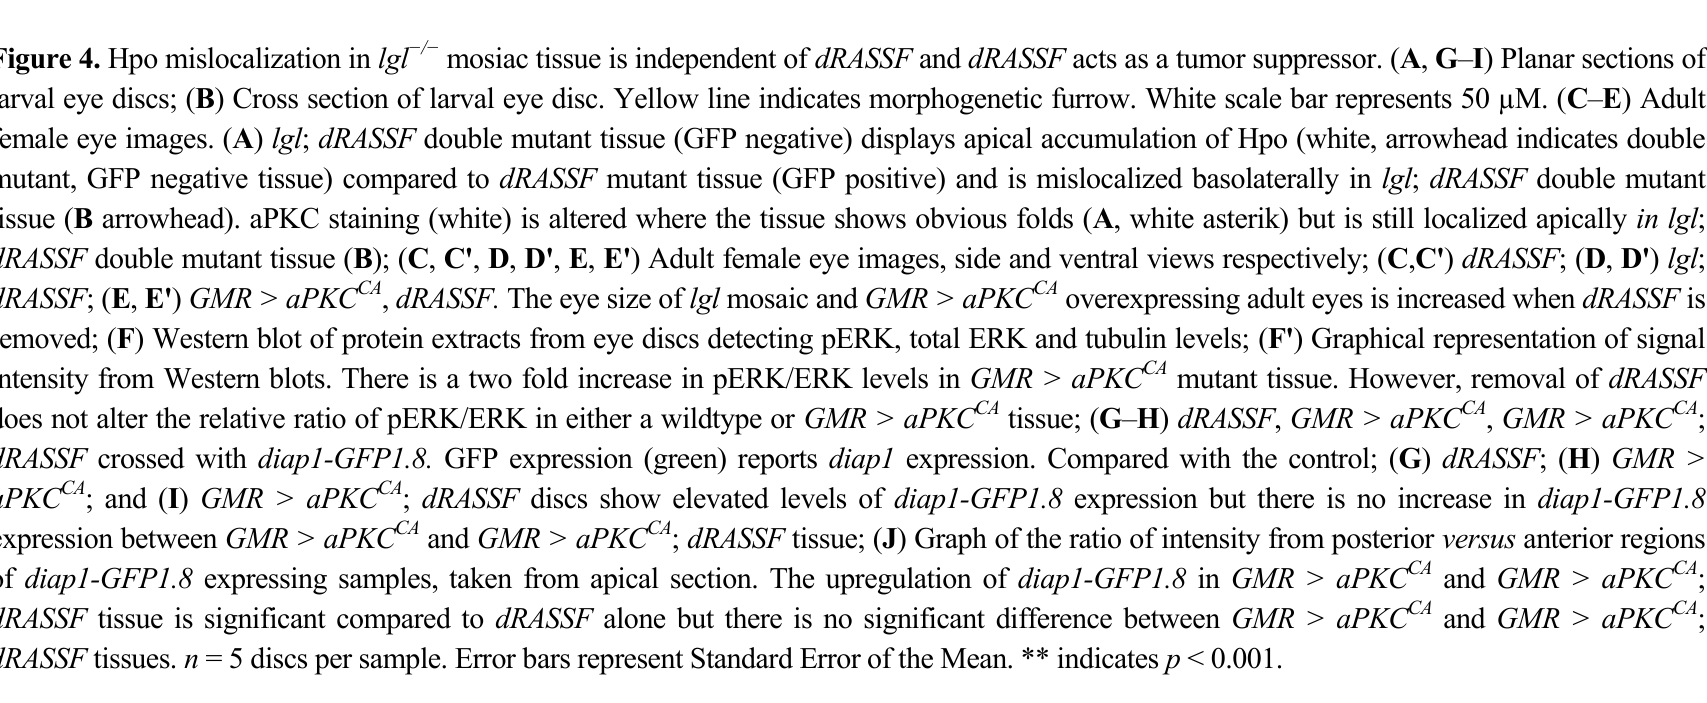
( A , B ) lgl ; dRASSF : eyFLP ; lgl 27S3 , FRT40/UbiGFP , FRT40 ; dRASSF X36/X36 ; ( C ) Control dRASSF : dRASSF X36/X36 ; ( D ) lgl ; dRASSF : eyFLP ; lgl 27S3 , FRT40/UbiGFP , FRT40 ; dRASSF X36/X36 ; ( E ) GMR > aPKC CA ; dRASSF : GMR-GAL4 > UAS-aPKC CAAXWT ; dRASSF X36/X36 ; ( F ) Control : w1118 , dRASSF : dRASSF X36/X36 , GMR>aPKC CA : GMR-GAL4 > UAS-aPKC CAAXWT GMR > aPKC CA ; dRASSF , GMR-GAL4 > UAS- aPKC CAAXWT ; dRASSF X36/X36 ; ( G ) Control dRASSF : GMR-GAL4 > diap1-GFP1.8/+ ; dRASSF X36/X36 ; ( H ) GMR > aPKC CA : GMR-GAL4 > diap1-GFP1.8/UAS-aPKC CAAXWT ; ( I ) GMR > aPKC CA ; dRASSF : GMR-GAL4 > diap1- GFP1.8/UAS-aPKC CAAXWT ; dRASSF X36/X36